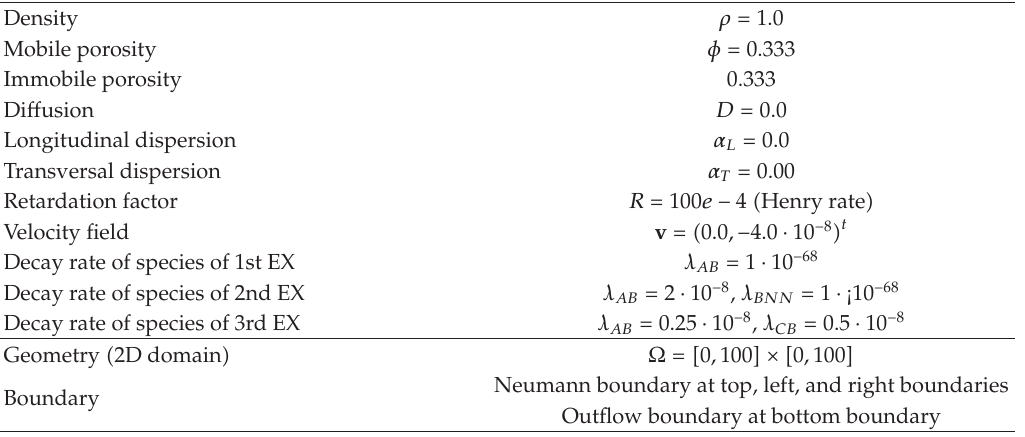
Table 8: Model parameters.